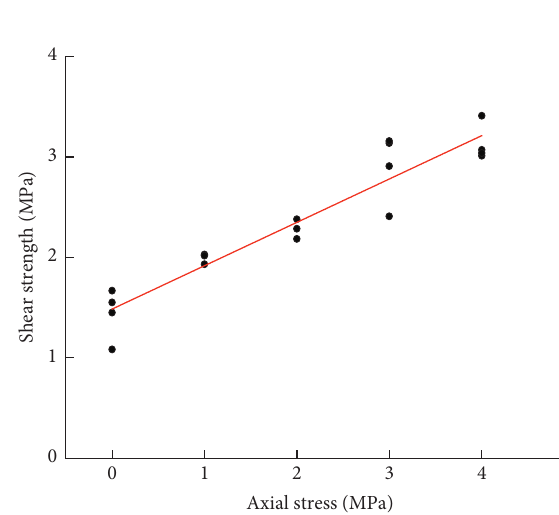
Figure 8: Relationship between shear strength and axial stress.